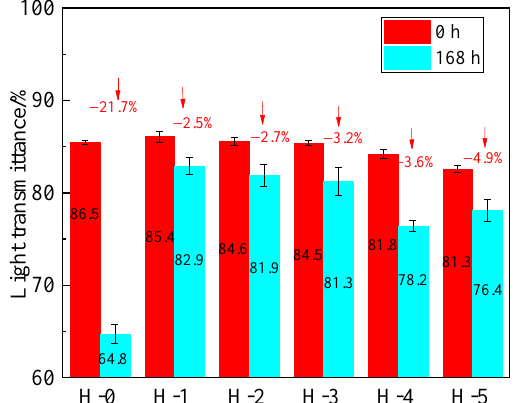
Figure 11. Light transmittance of the transparent flame-retarded hydrogel before and after accelerated ageing test.